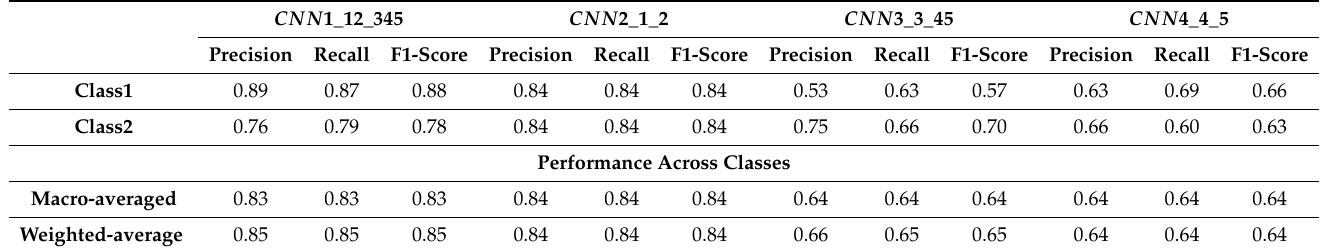
Table 4. Classification accuracy for the third level (50 × 50) of our proposed model, containing four